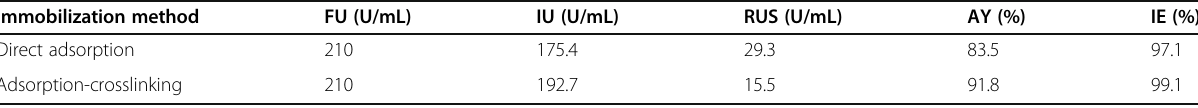
Table 2 Immobilization efficiency of lipase on chitosan beads Immobilization